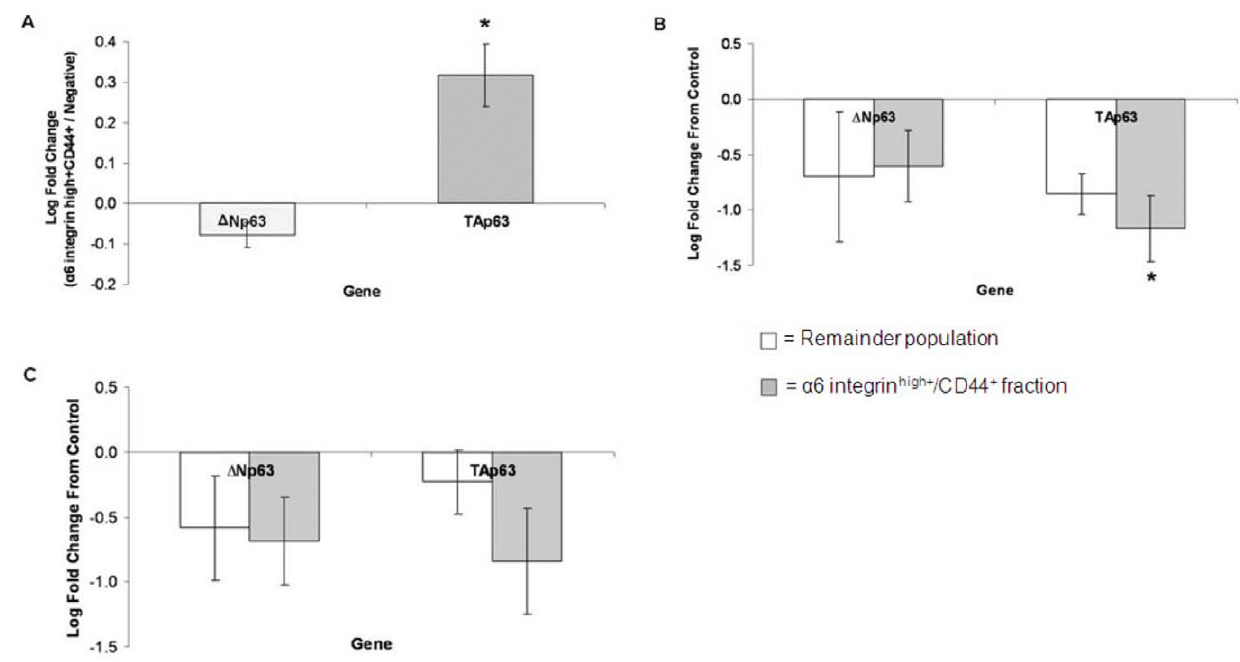
Figure 6. p63 gene expression. (A) Primary keratinocytes analysed for p63 gene expression in the a 6 integrin high + /CD44 + and remainder populations using QRT-PCR. Data represents the log mean fold change of the a 6 integrin high + /CD44 + population from the remainder population 6 SEM of three replicates, normalised against GAPDH housekeeping gene. Keratinocytes analysed for gene expression after cisplatin (B) or UVB (C) where data represents the log mean fold change from the control (vehicle-only) 6 SEM of three replicates, normalised against 28S-r-RNA housekeeping gene. Statistical significance was determined using the paired Student’s t-test, *P , 0.05. mRNA level in the a 6 integrin high + /CD44 + cells compared to the remainder population when quantified using QPCR (p , 0.05, Figure 6A). Gene expression of the truncated D Np63 isoform did not differ between the two keratinocyte fractions. Cisplatin